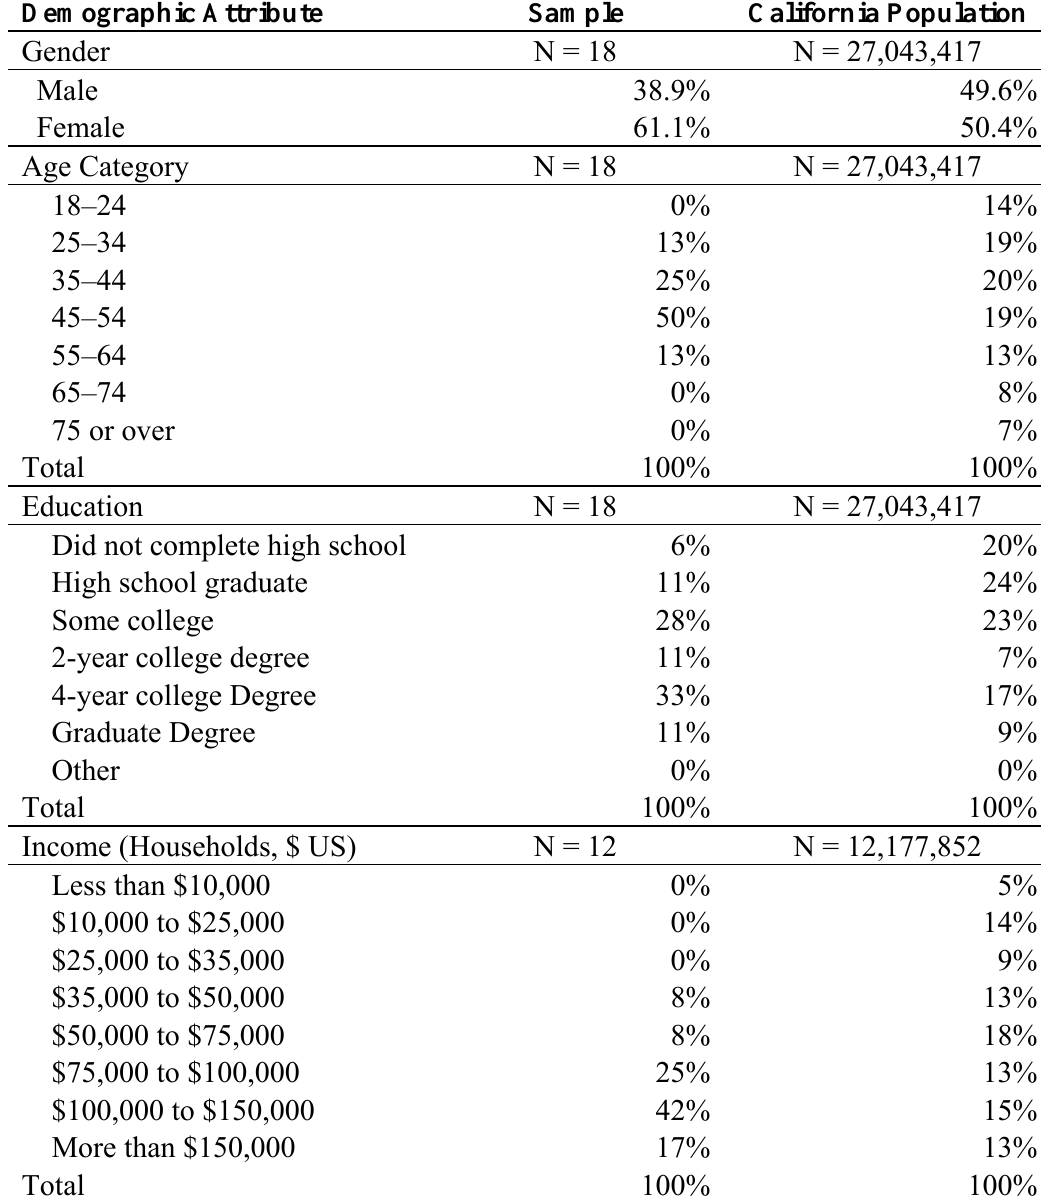
Table 2. Demographics of study drivers and the California